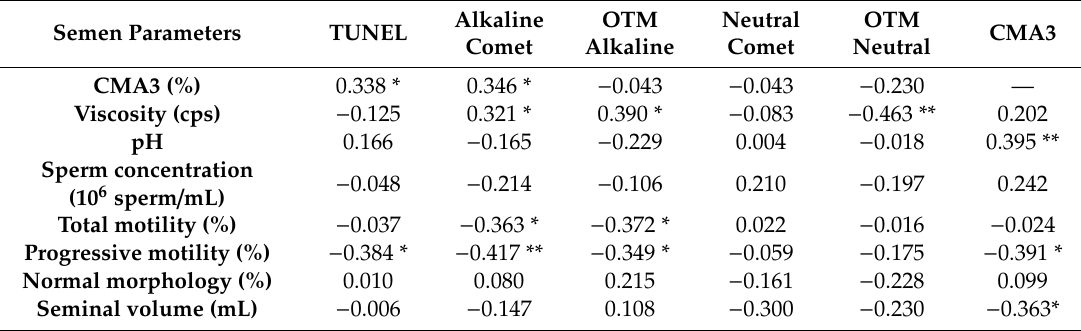
Table 4. Sperm DNA fragmentation (SDF) and chromomycin a3 (CMA3) correlation analysis with semen and sperm parameters with Pearson’s and Spearman’s correlation test as it matches. Alkaline OTM Neutral OTM CMA3 Semen Parameters TUNEL Comet Alkaline Comet Neutral CMA3 (%) 0.338 * 0.346 * − 0.043 − 0.043 − 0.230 — Viscosity (cps) − 0.125 0.321 * 0.390 * − 0.083 − 0.463 ** 0.202 pH 0.166 − 0.165 − 0.229 0.004 − 0.018 0.395 ** Sperm concentration − 0.048 − 0.214 − 0.106 0.210 0.242 (10 6 sperm / mL) Total motility (%) − 0.037 − 0.363 * − 0.372 * 0.022 − 0.016 − 0.024 Progressive motility (%) − 0.384 * − 0.417 ** − 0.349 * − 0.059 − 0.175 − 0.391 * Normal morphology (%) 0.010 0.080 0.215 − 0.161 − 0.228 0.099 Seminal volume (mL) − 0.006 − 0.147 0.108 −